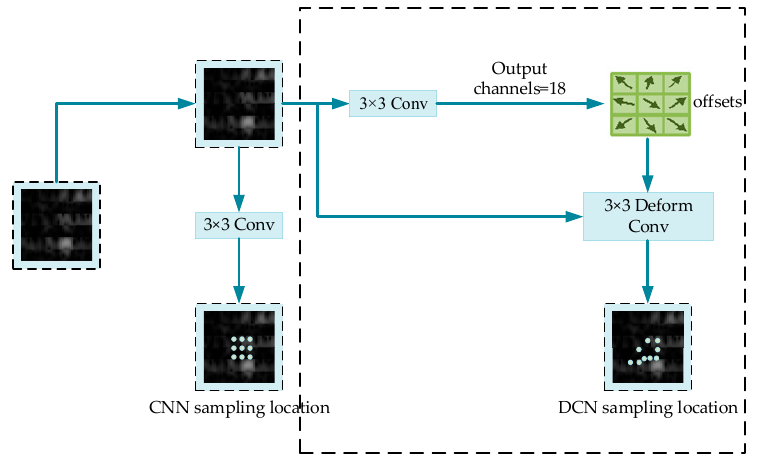
Figure 2. 3 × 3 Diagram of the deformable convolutional operation mechanism.